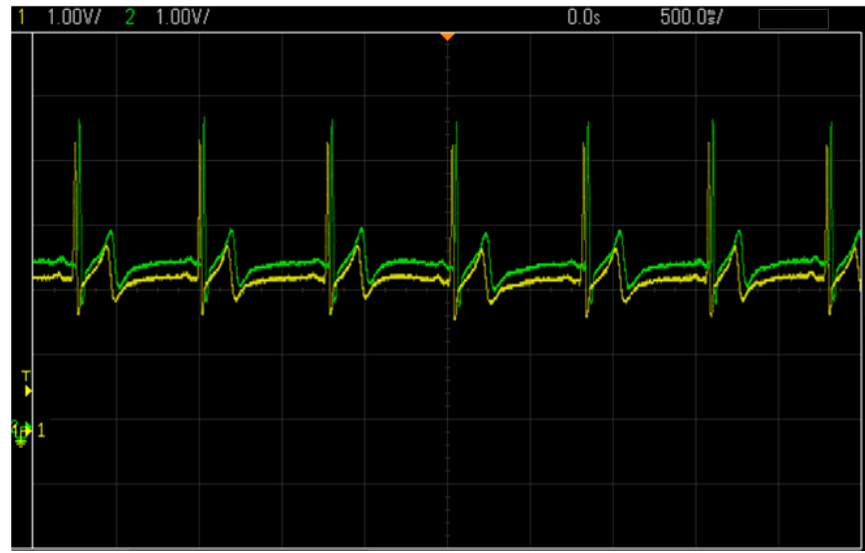
Figure 24. EMG with Raspberry Pi.